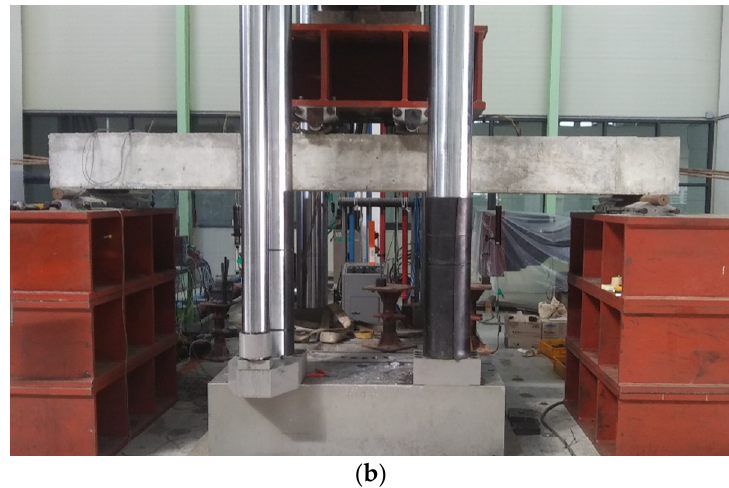
Figure 6. Test setup for two-point loading: ( a ) Schematic test setup; ( b ) Photograph of test setup.